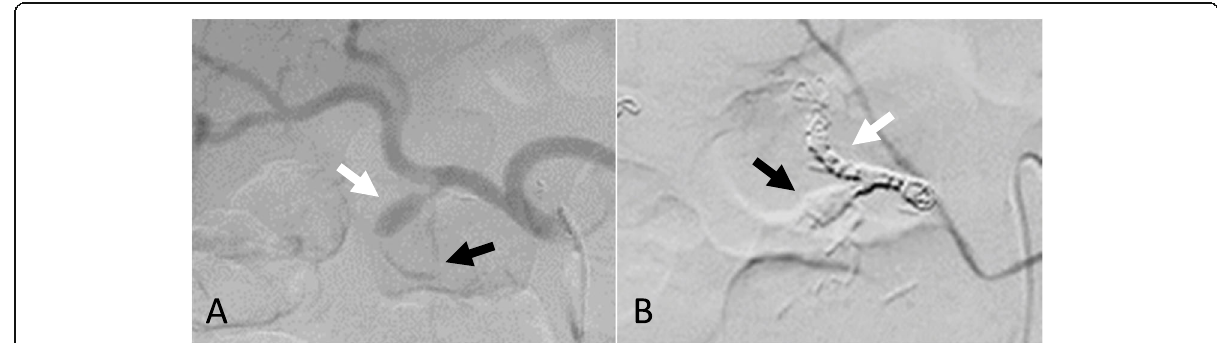
Fig. 5 Angiography findings. Angiogram ( a ) showing the pseudoaneurysm developed from the proximal gastroduodenal artery (white arrow) and the posterior superior pancreaticoduodenal artery branched from the pseudoaneurysm (black arrow). Angiogram after transcatheter arterial embolization ( b ) showing the complete hemostasis of the pseudoaneurysm with coils (white arrow) and N-butyl-2-cyanoacrylate (black